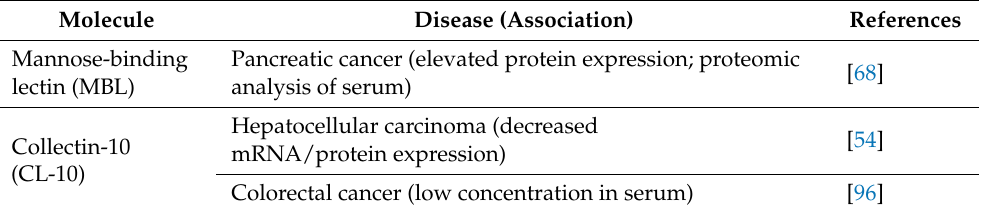
Table 1. Components of the lectin pathway of complement as candidate biomarkers of solid tu- mour